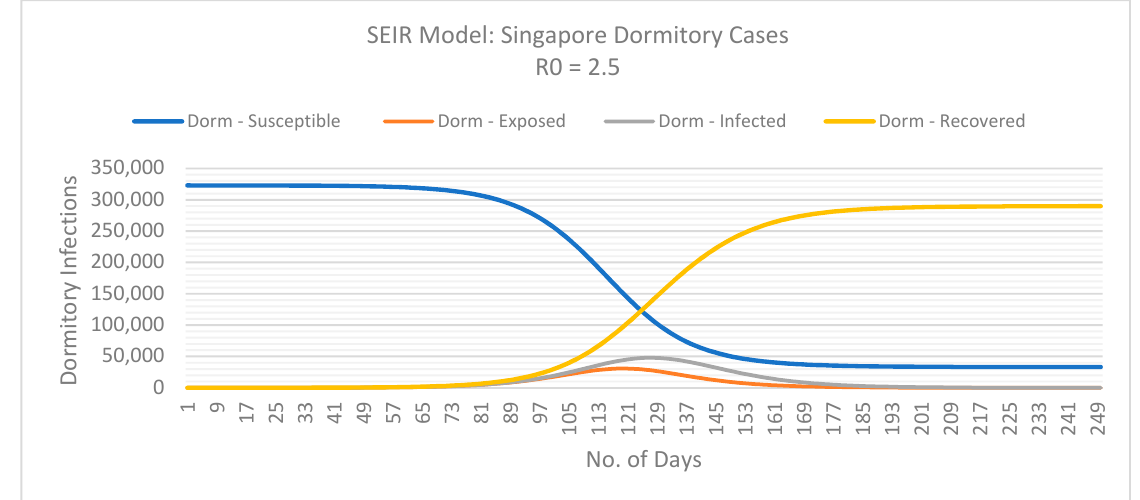
Figure 5. Predicted dynamics of the COVID-19 outbreak within the migrant worker population in Singapore living in dormitories. Basic reproduction number ( R 0) is 2.5. Data retrieved from the Singapore Ministry of Health and the WHO [68,69].